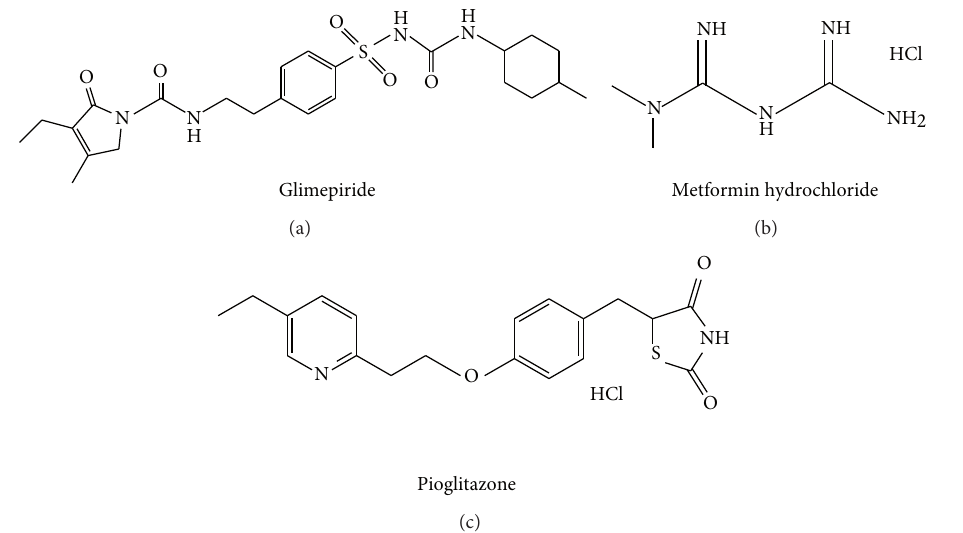
F 1: Chemical structures of the drugs.